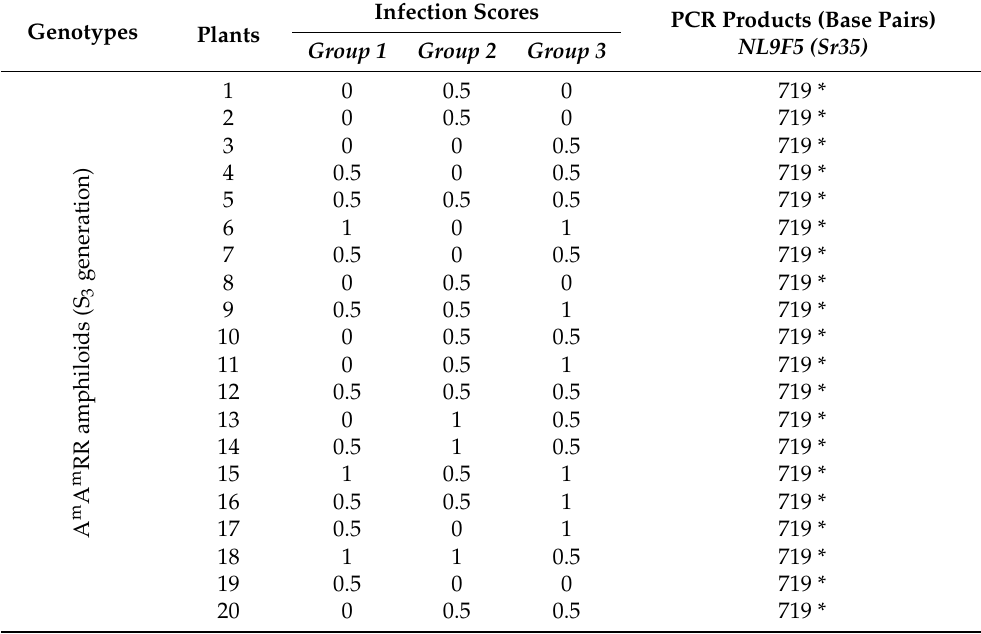
Figure 5. Infection scores collected from three experimental trials. Each trial consisted of 1–20 S 4 and following control genotypes: T. aestivum “Thatcher”, (susceptible control, Sus1–Sus10) and T. aestivum Thatcher + Sr57 (moderate resistant control, Mod1—Mod10). Infection types (ITs) were scored according to Stakman et al. (1962): “0”, “1”, “2”—resistant; “3” to “4”—susceptible.